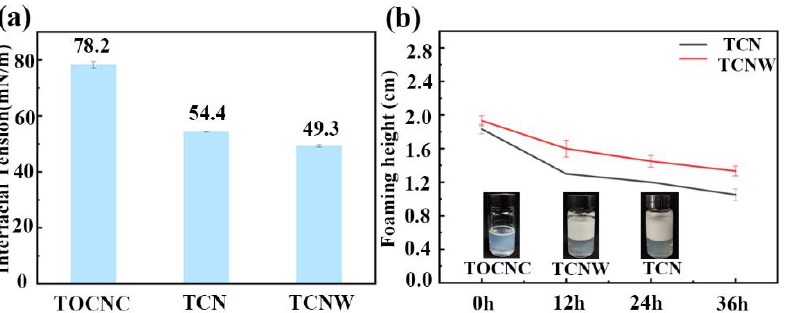
Figure 2. ( a ) Interfacial tensions of particle suspensions. ( b ) The suspension foaming heights at different times and foaming effect pictures.